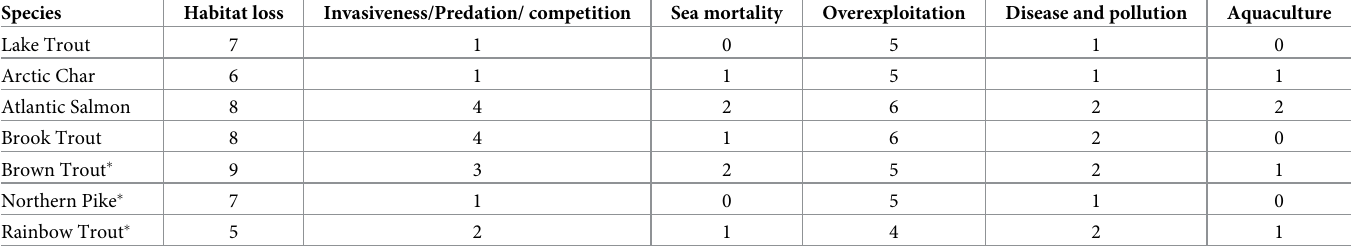
Table 4. Non-climatic drivers of vulnerability for the selected species. Experts provided a total of 128 responses which were grouped into 6 categories. � indicates non- native species.